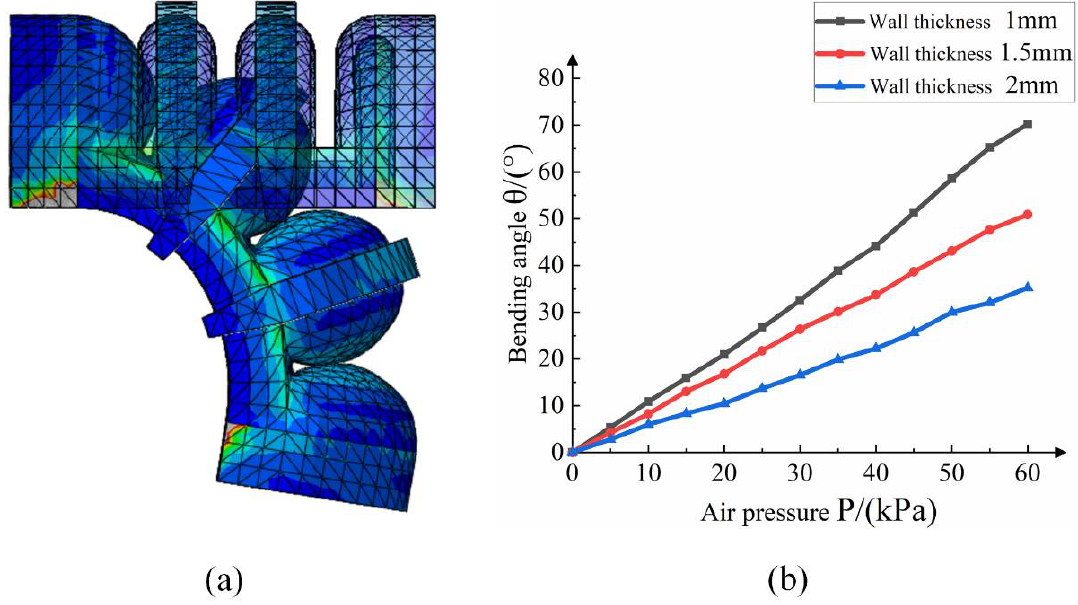
Figure 10. ( a ) Schematic diagram of joint bending simulation; ( b ) effect of different air cavity wall thickness on bending performance.